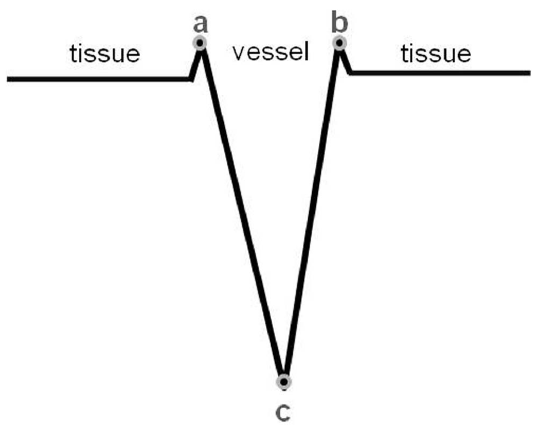
Figure 1. Phase profile showing the susceptibility change from the tissue and vessel. We measure Dw a , Dw b and Dw c , so the average phase change cross the vessel DQ ~ ( DQ a { DQ c ) z ( DQ b { DQ c )